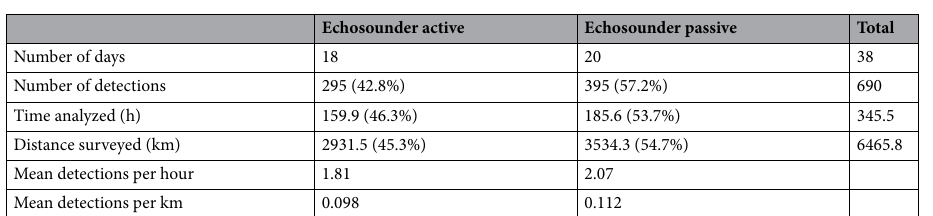
Table 1. Passive acoustic effort and acoustic detections of usual click trains when the echosounder was in active and passive modes. 38 of the 39 survey days were included; August 24 was excluded because the echosounder state changed during the